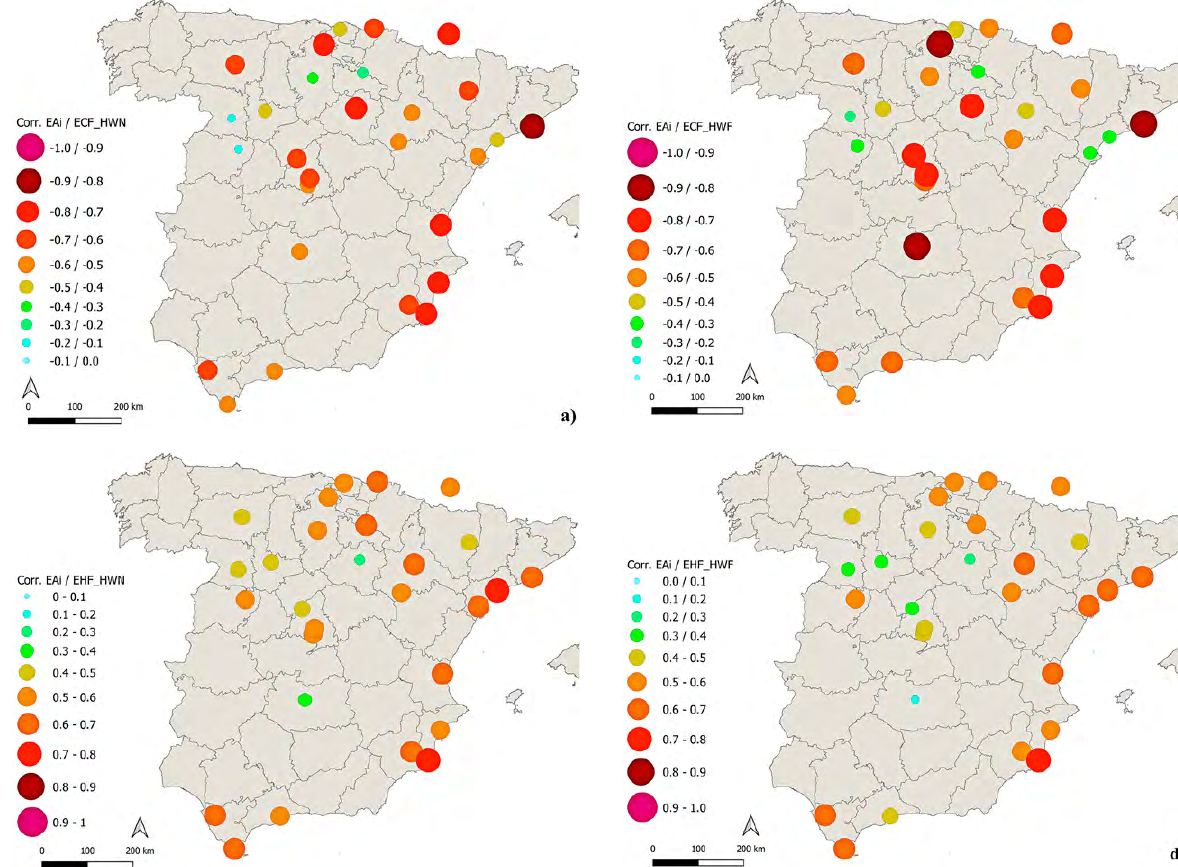
Figure 8. Kendall rank correlation coefficients between the EA index vs. a) ECF_HWN, b) ECF_HWF, c) EHF_HWN and d) EHF_HWF, displayed for each observatory